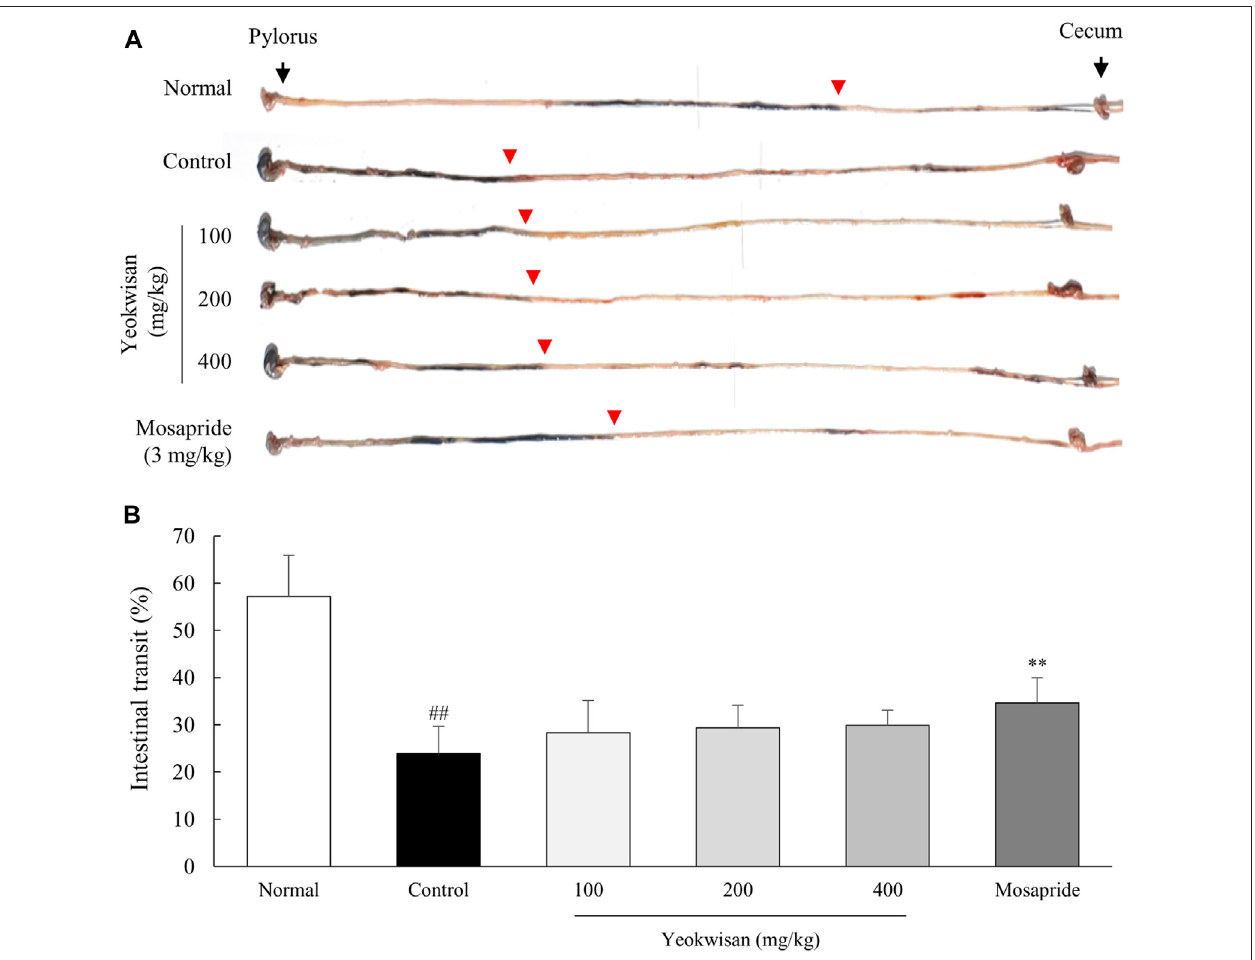
FIGURE 3 | Effects of Yeokwisan on small intestinal transit. For 5 days, the mice (n (cid:2) 6/group) were orally administered Yeokwisan (100, 200 and 400 mg/kg) or mosapride (3 mg/kg) and then intraperitoneally injected with loperamide (10 mg/kg). Thirty minutes after the administration of charcoal diets, the transit distance of the diet was measured (A) and quanti fi ed (B) . Red arrowheads indicate how much charcoal diet moved into the cecum. The data are presented as the mean ± SEM. ## p < 0.01 compared with the normal group; ** p < 0.01 compared with the control group.